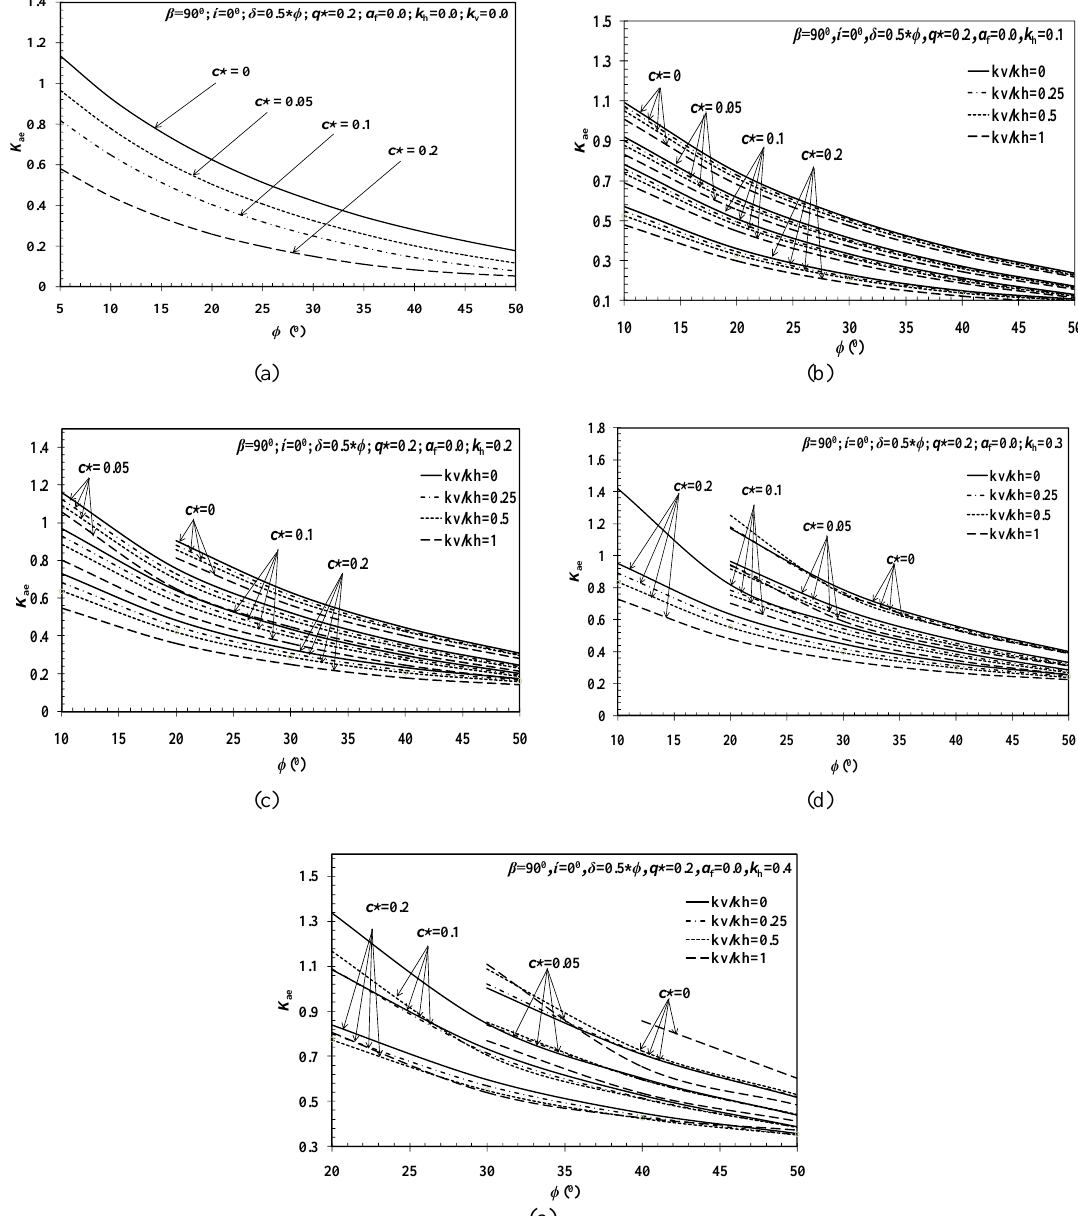
Figure 2. Design charts for K ae for backfill slope i = 0 o and wall inclination β = 90